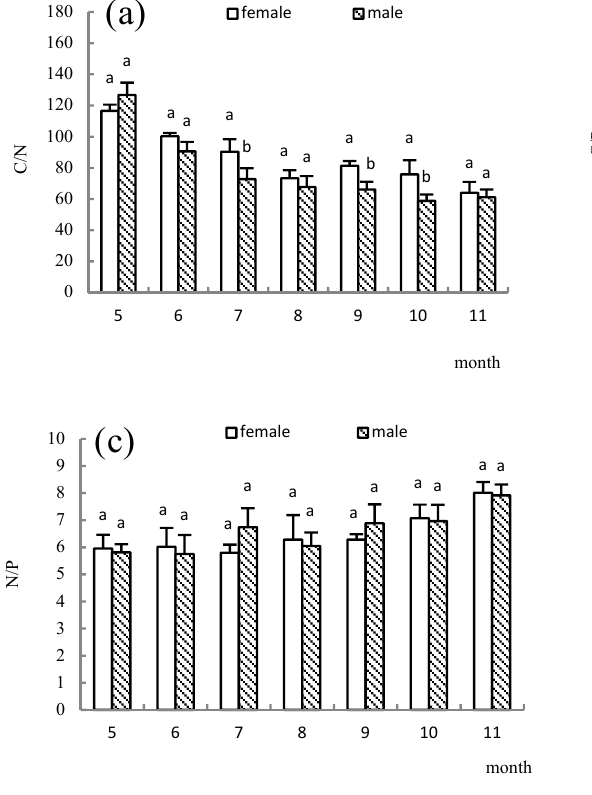
Figure 8. Comparation of C/N ( a ), C/P ( b ), N/P ( c ) ratios in branch of female and male plants of F. velutina during the growing season. Note: Means not sharing the same letter of female and male plants in the same month indicated significant differences between males and females at an alpha level of 0.05, according to one-way ANOVA.